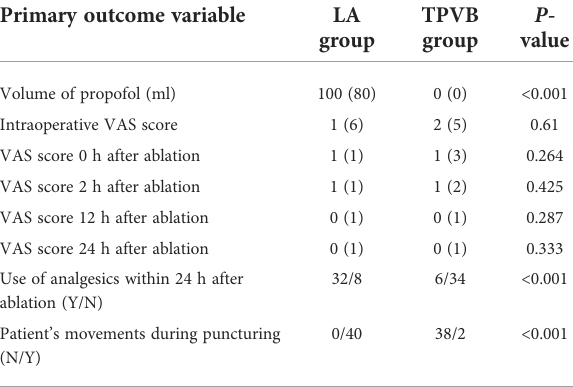
TABLE 2 Comparison of propofol volume, VAS scores, and use of analgesics within 24 h after ablation between the two groups.